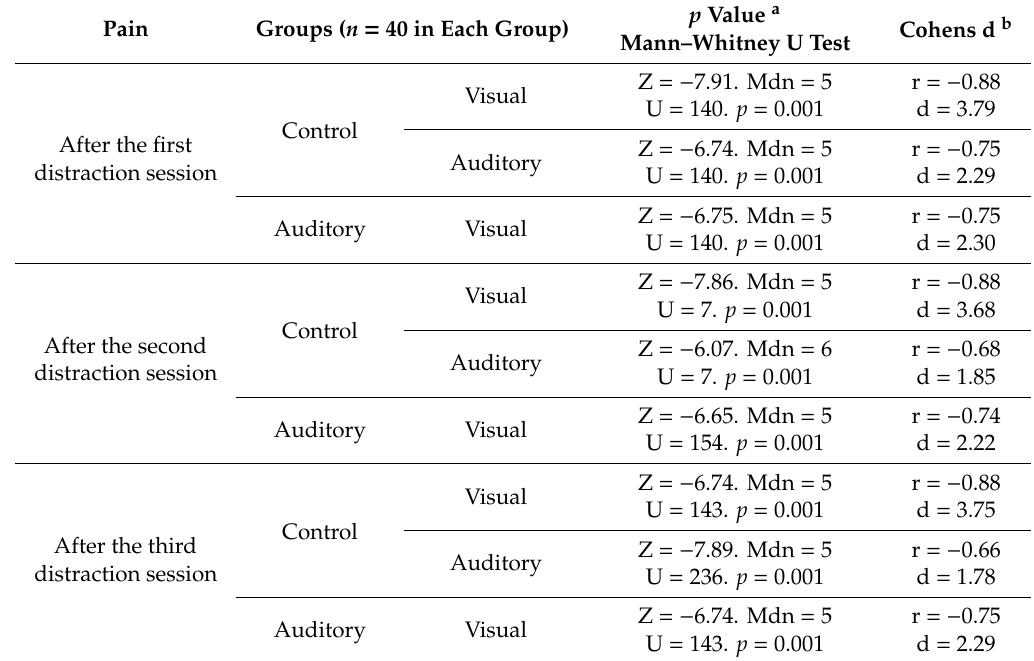
Table 3. The pairwise comparison of pain severity in the